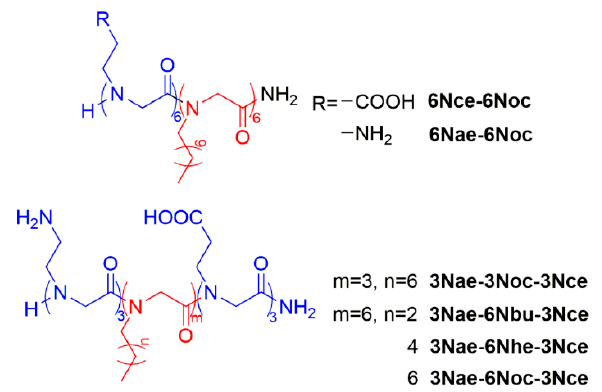
Polymers 2021 , 13 , x FOR PEER REVIEW Figure 2. Structures of sequence-defined peptoid block copolymers . Figure 2. Structures of sequence-defined peptoid block copolymers.